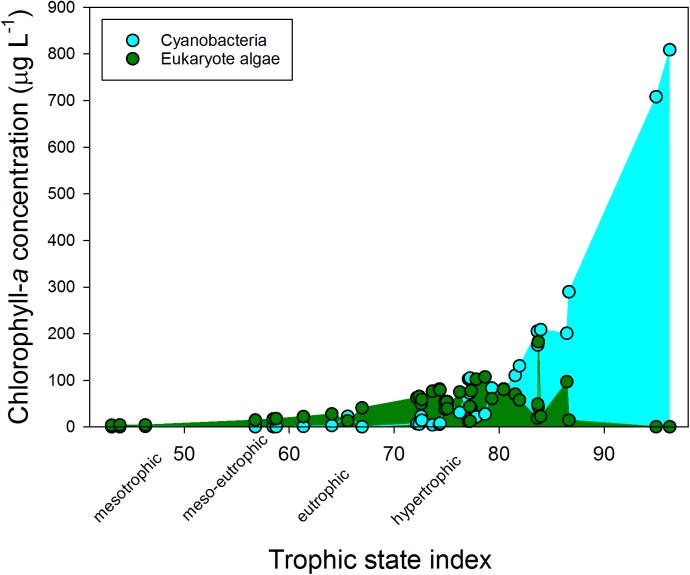
Cyanobacterial (blue) and eukaryote phytoplankton (green) chlorophyll-a concentrations (μg l−1) in fresh waters sampled in the Netherlands in summer 2010 and that were used in the experiments. The trophic state index is calculated from the total chlorophyll-a concentrations according to Carlson (1977).